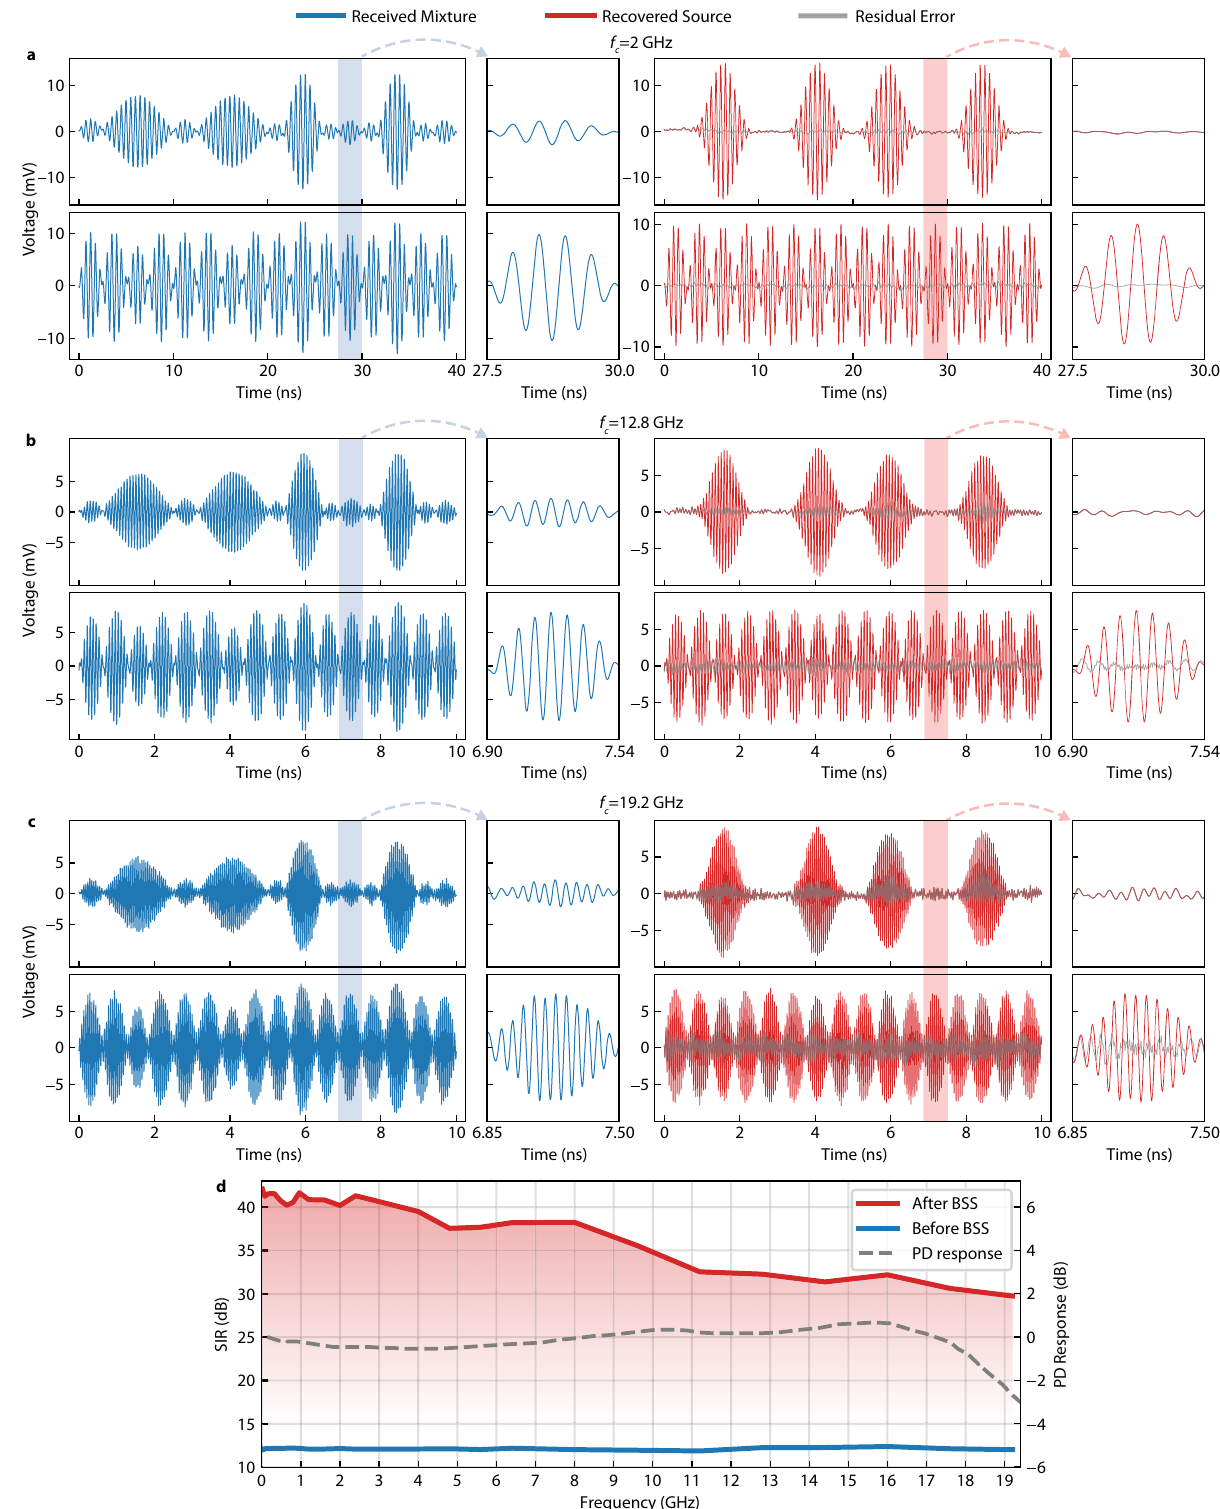
Fig. 4 | Broadband BSS with a single photonic chip. a – c BSS results, mixtures (blue)andestimatedsources(red)withcarrierfrequenciesof2,12.8,and19.2GHz, respectively. The residual errors are in grey. d SIR of the received mixtures (blue